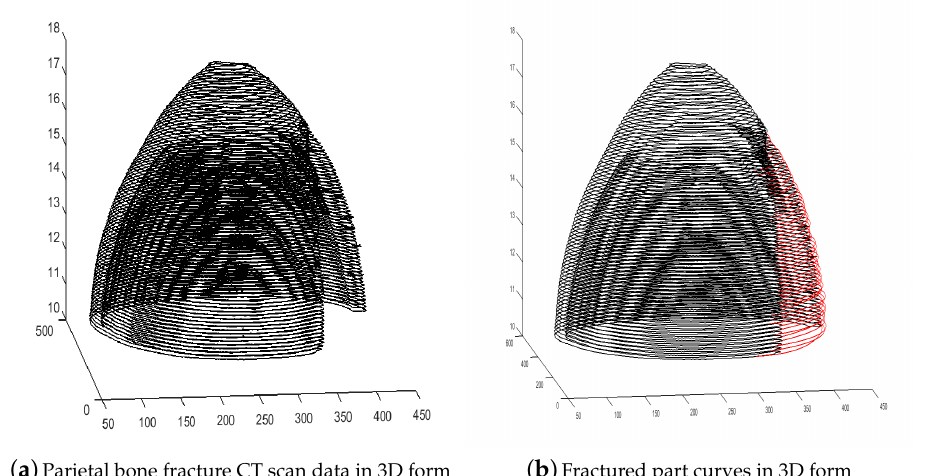
Figure 18. Parietal bone fracture data in 3D